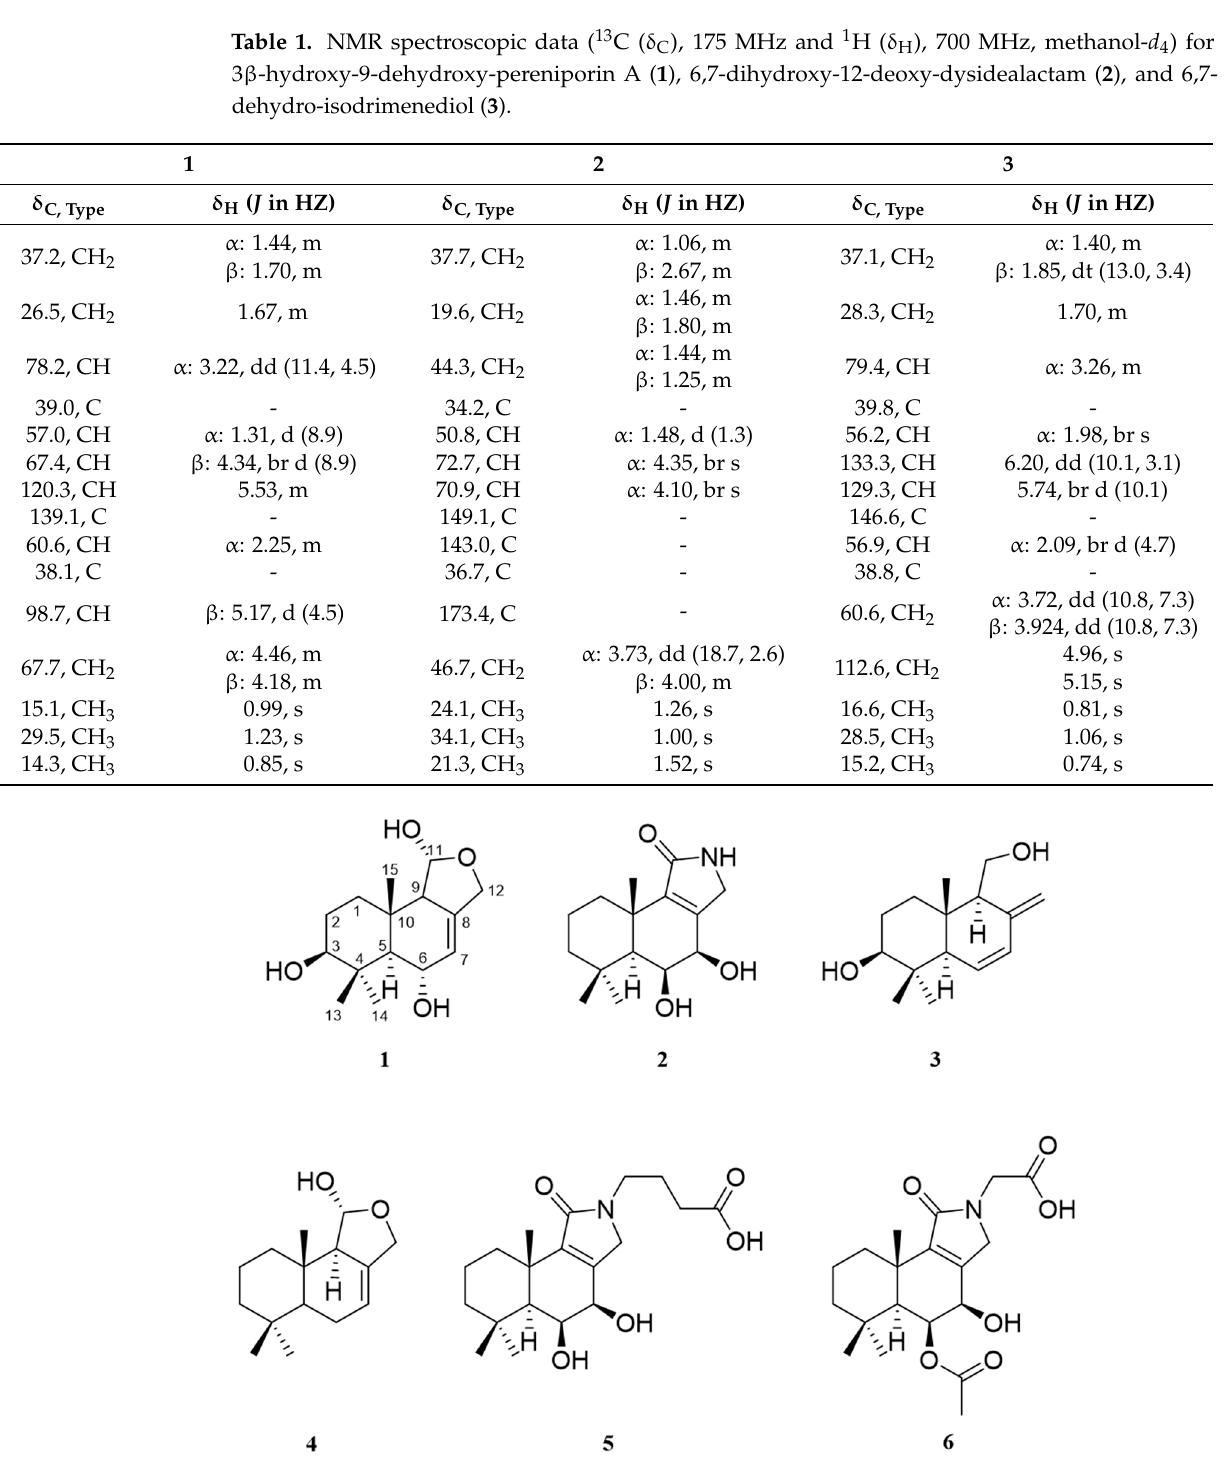
Table 1. NMR spectroscopic data ( 13 C ( δ C ), 175 MHz and 1 H ( δ H ), 700 MHz, methanol- d 4 ) for